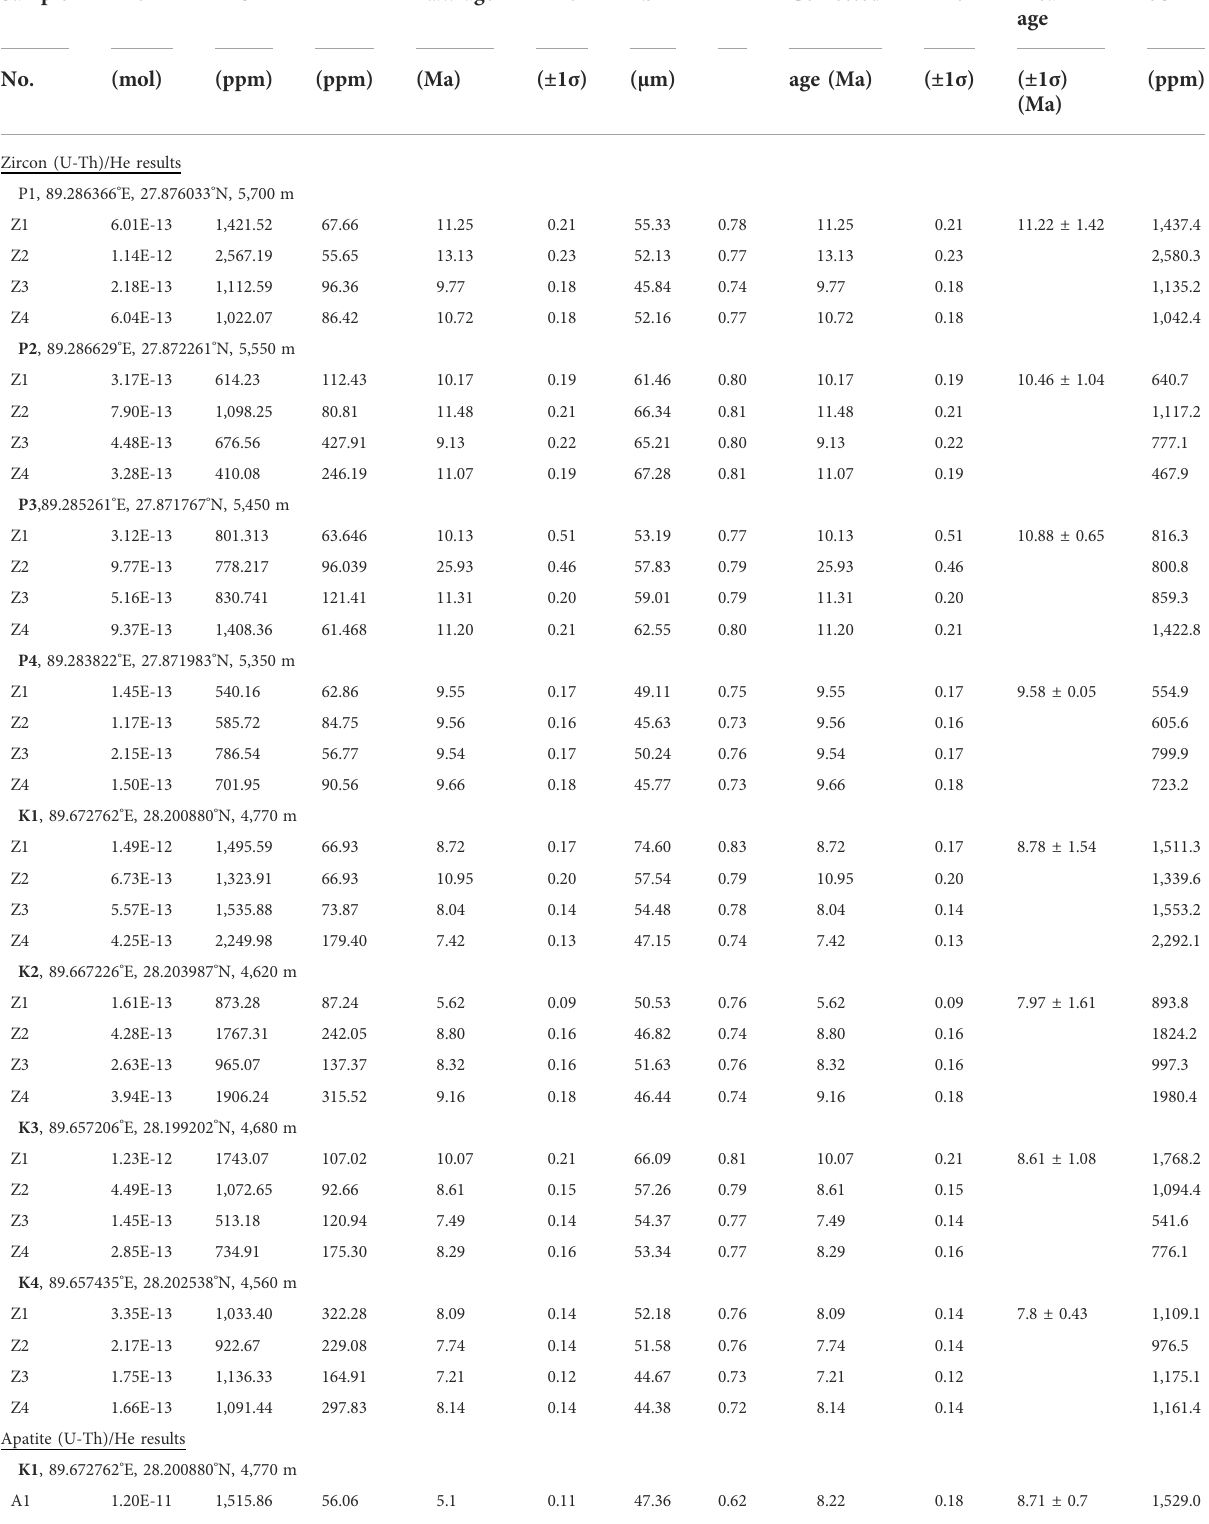
TABLE 1 Single-grain zircon an apatite (U-Th)/He results from Leucogranite along southern section of YGR.